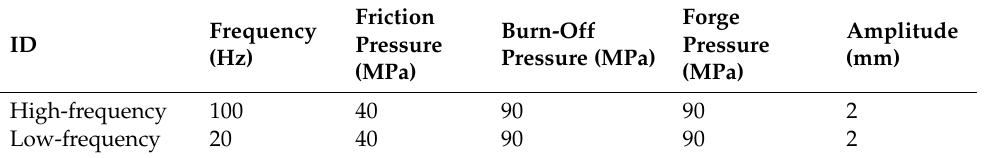
Table 2. LFW parameters used to join CPM 15V steel and the low-carbon steel.